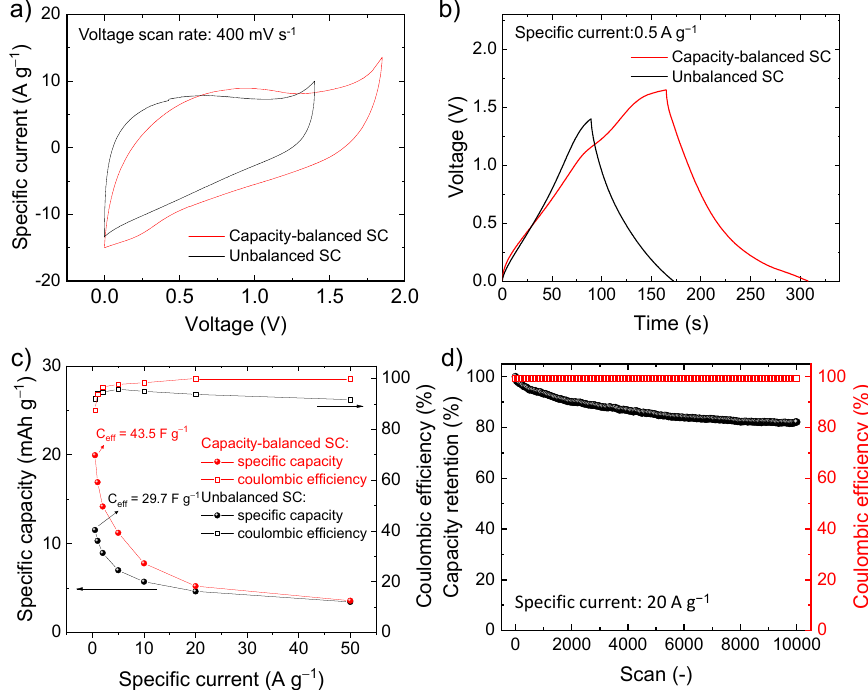
Figure 6. ( a ) Comparison between the CV curves measured for unbalanced SC and capacity balanced SC-based on C-Fe 2 O 3 electrodes (voltage scan rate = 400 mV s − 1 ); ( b ) comparison between the galvanostatic CD curves measured for unbalanced SC and capacity balanced SC based on C-Fe 2 O 3 electrodes (specific current = 0.5 A g − 1 ); ( c ) capacity and CE of the quasi-symmetric SC as a function of the specific current; ( d ) capacity retention and CE over 10,000 galvanostatic CD cycles (specific current = 20 A g − 1 ).